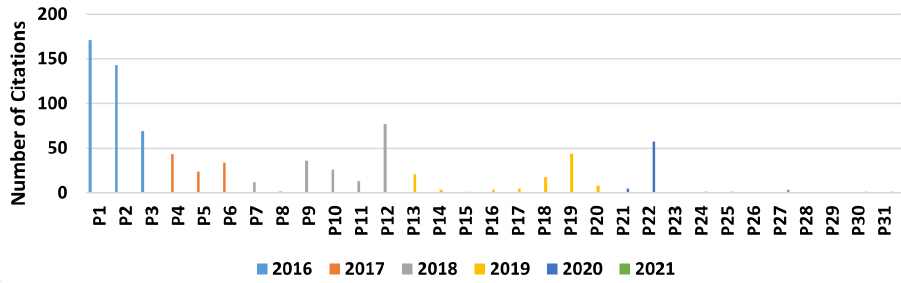
Figure 10. Paper citations by publication year.